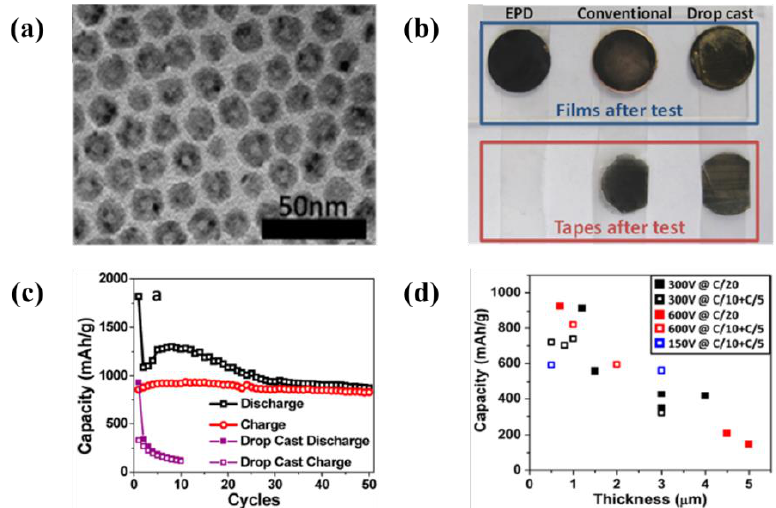
Figure 11. Co 3 O 4 nanoparticle films prepared by EPD as the anode for Li-ion batteries: ( a ) TEM image of Co 3 O 4 nanoparticles; ( b ) Mechanical stability test of the Co 3 O 4 nanoparticle films prepared by EPD, conventional slurry, and drop casting; ( c ) Capacity retention of Co 3 O 4 nanoparticle films at a rate of 0.05 C showing the charge (red circles) and discharge (black squares); ( d ) Relationship between the average film thickness and the charge capacity for different applied voltages during EPD.